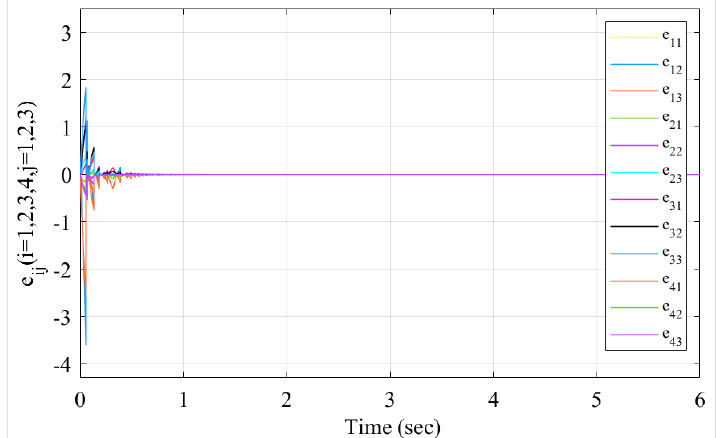
Figure 5. Error trajectories of nodes without DoS attacks.